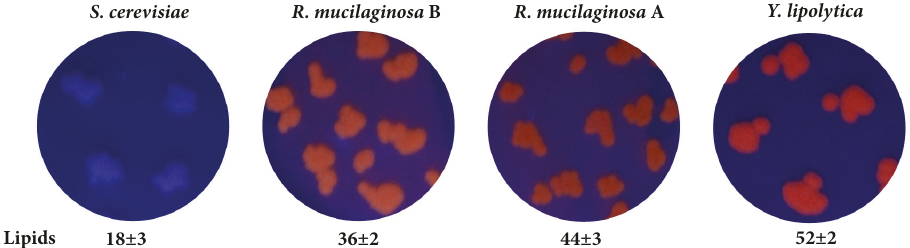
Figure 6: Visualization of the strains under UV light after incubation in rich medium (YPD) with 10 mg/L Rhodamine B for up to four days. The lipid content was measured in